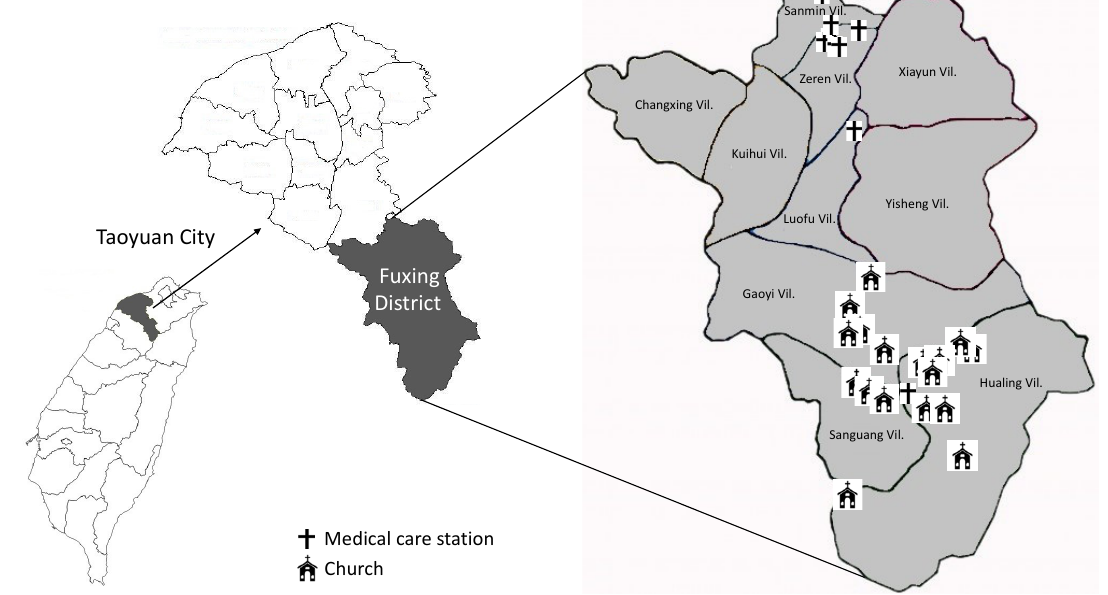
Figure 1. Geographical information of the remote area of the Fuxing District.